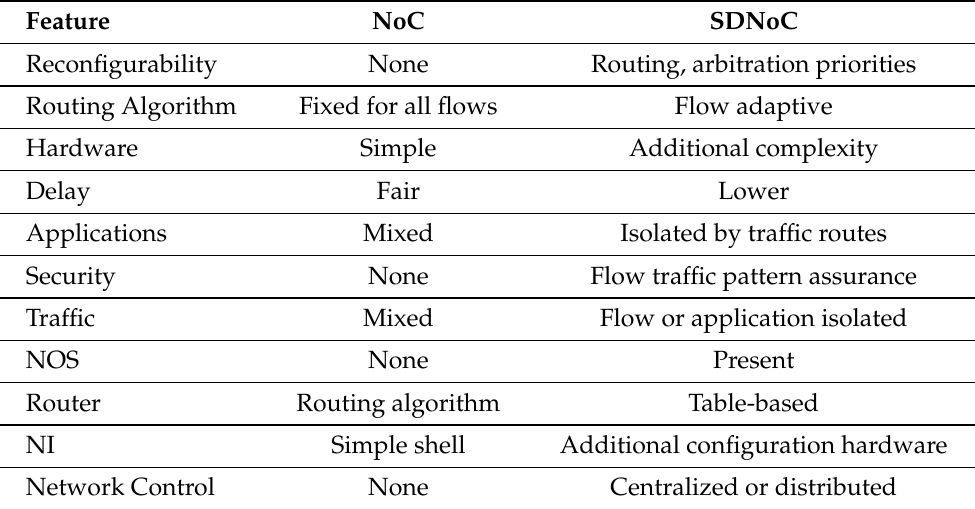
Table 5. Feature comparison for NoC versus